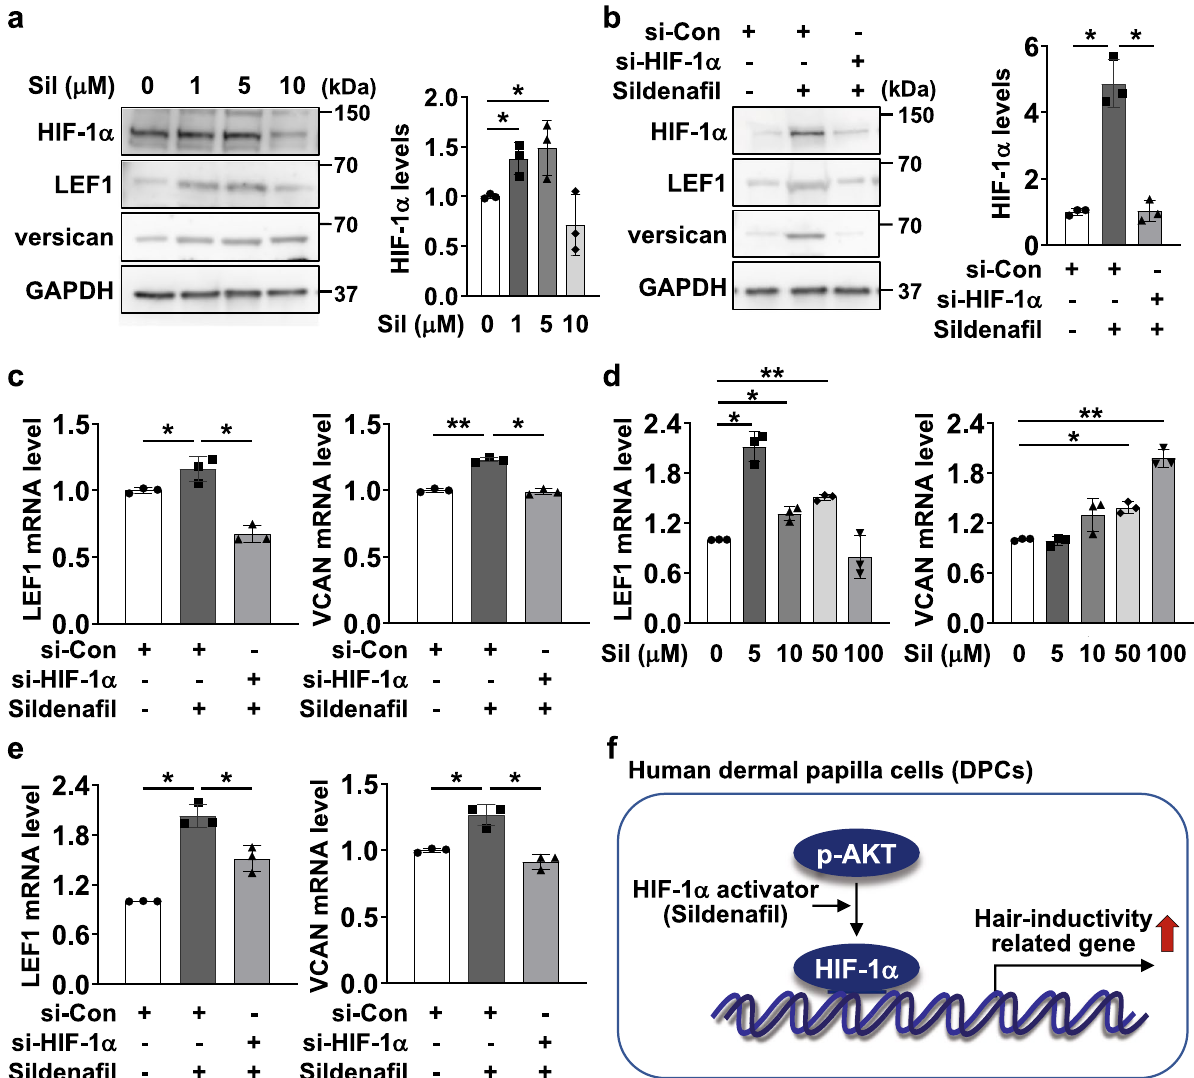
Figure 4. The HIF-1α activator sildenafil activates trichogenic gene expression in DPCs. (a) DPCs were incubated with sildenafil (1, 5, 10 mM) for 24 h and subjected to western blotting. Quantification was performed based on GAPDH expression levels by using ImageJ. (b,c) Cells were transfected with si-Con or si-HIF-1α and then treated with 5 mM sildenafil for 24 h. Cell lysates were subjected to western blotting (following quantification of the blots, b ) or RT ‒ qPCR ( c ). (d) DPC spheroids were incubated with sildenafil (5, 10, 50, 100 mM) for 24 h and lysed for RT ‒ qPCR to determine LEF1 and VCAN mRNA levels. (e) si-Con- or si-HIF-1α-transfected DPCs were utilized for 3D culture. The formed spheroids were lysed for RNA extraction, and RT ‒ qPCR was performed. (f) The proposed mechanism by which HIF-1α accelerates trichogenic gene expression levels in DPCs. The data are presented as the means and SD calculated with data from 3 independent region is created as an indispensable region due to poor oxygen permeability as a solid tumor. In human solid tumors, the intrahypoxia region accounts for 19% to 70% of the tumor volume; thus, adaptation to hypoxia via the induction of HIF-1α is essential for cell survival and function 30,31 . Therefore, the upregulation of HIF-1α is a reasonable consequence in forming DPC spheroids, but the result might imply a positive correlation between HIF-1α and hair inductivity. We revealed that HIF-1α-KD DPC spheroids exhibited lower expression of hair inductivity-related genes, indicating that HIF-1α is responsible for regulating hair inductivity in DPC spheroids. Finally, we further demonstrated that sildenafil, which is also known as a HIF-1α activator, could accelerate trichogenic gene expression levels in DPCs and DPC spheroids. Previously, Choi et al. revealed that sildenafil increases hair growth in C57BL/6 mice, but the detailed mechanisms were unknown 32 . a Furthermore, hypoxic conditions are known to elevate DP cell proliferation and hair inductivity, but they are not suitable for long-term cell culture because prolonged hypoxia can induce cell death 12,13,33 . Based on our results, treating sildenafil could